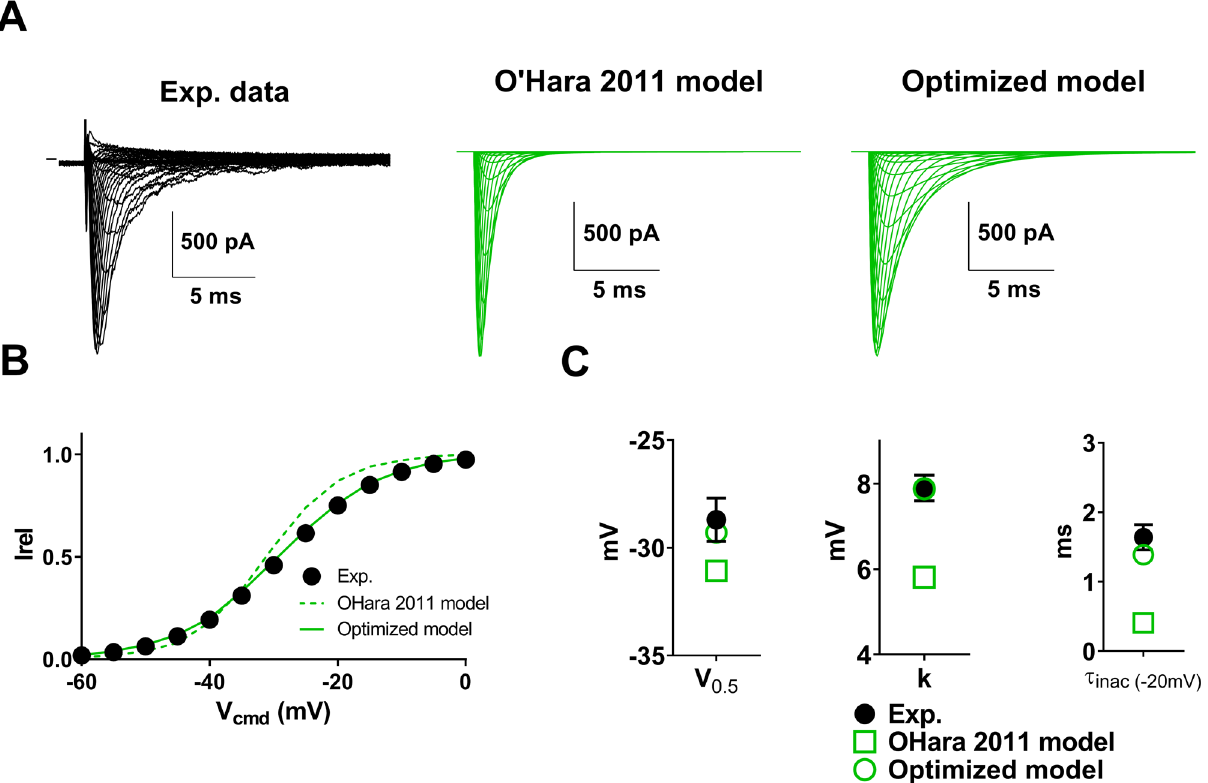
Figure 6. Optimization of the Kinetic model presented in Fig. 2 to fit the recordings of heterologously- expressed Na v 1.5. (A ) Left, representative, superimposed recordings of heterologously-expressed Na v 1.5 during an activation voltage protocol (same as in Fig. 2). Middle, computed recordings using the same protocol, and the equation of 5 . Right, computed recordings using the same protocol, and the optimized model, to fit the biophysical characteristics of heterologously-expressed Na v 1.5. ( B ) Activation curves in the three conditions presented in (A) . ( C ) Half-activation potentials, slopes and time constants of inactivation in the three